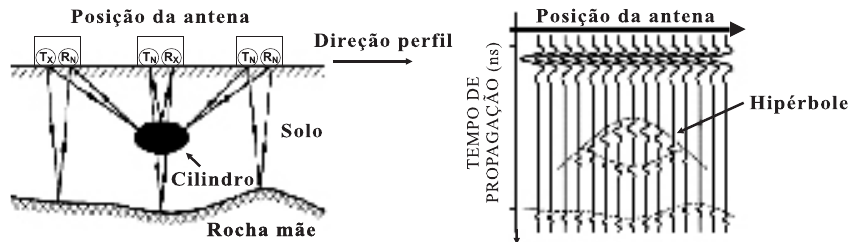
Figura 1. Esquema ilustrativo do método utilizado para determinação da constante dielétrica. Adaptado de Cruz et al.